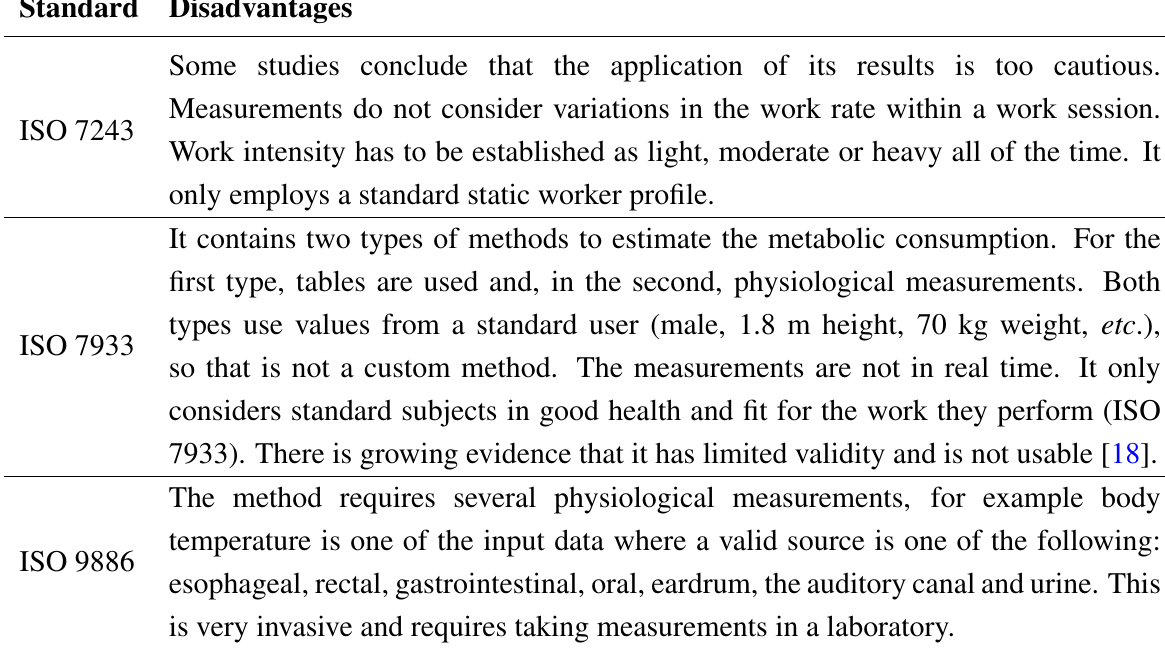
Table 1. Related ISO standards’